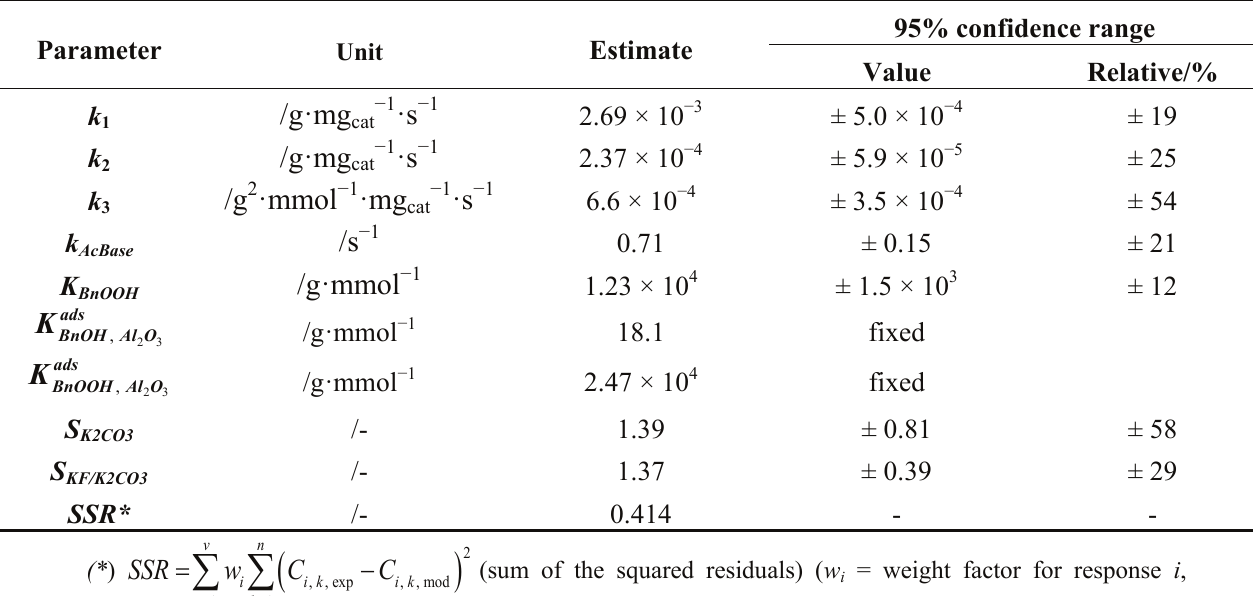
Table 2. Optimal estimates of the kinetic parameters using all experimental data. Parameter Unit Estimate − 1 ·s − 1 2.69 × 10 − 3 ± 5.0 × 10 − 4 ± 19 /g·mg k cat 1 − 1 ·s − 1 2.37 × 10 − 4 ± 5.9 × 10 − 5 ± 25 /g·mg k cat 2 − 1 ·s − 1 6.6 × 10 − 4 ± 3.5 × 10 − 4 ± 54 /g 2 ·mmol − 1 ·mg k cat 3 /s − 1 0.71 ± 0.15 ± 21 k AcBase /g·mmol − 1 1.23 × 10 4 ± 1.5 × 10 3 ± 12 ads K /g·mmol − 1 18.1 fixed BnOH Al O 2 3 , ads K /g·mmol − 1 2.47 × 10 4 fixed BnOOH Al O 2 3 , /- 1.39 ± 0.81 ± 58 /- 1.37 ± 0.39 ± 29 S KF/K2CO3 SSR* /- 0.414 - - C (sum of the squared residuals) ( w v = number of responses, C i , k , exp = experimental response of component i in experiment k , C i , k , mod = model response of component i in experiment k , n = number of experiments